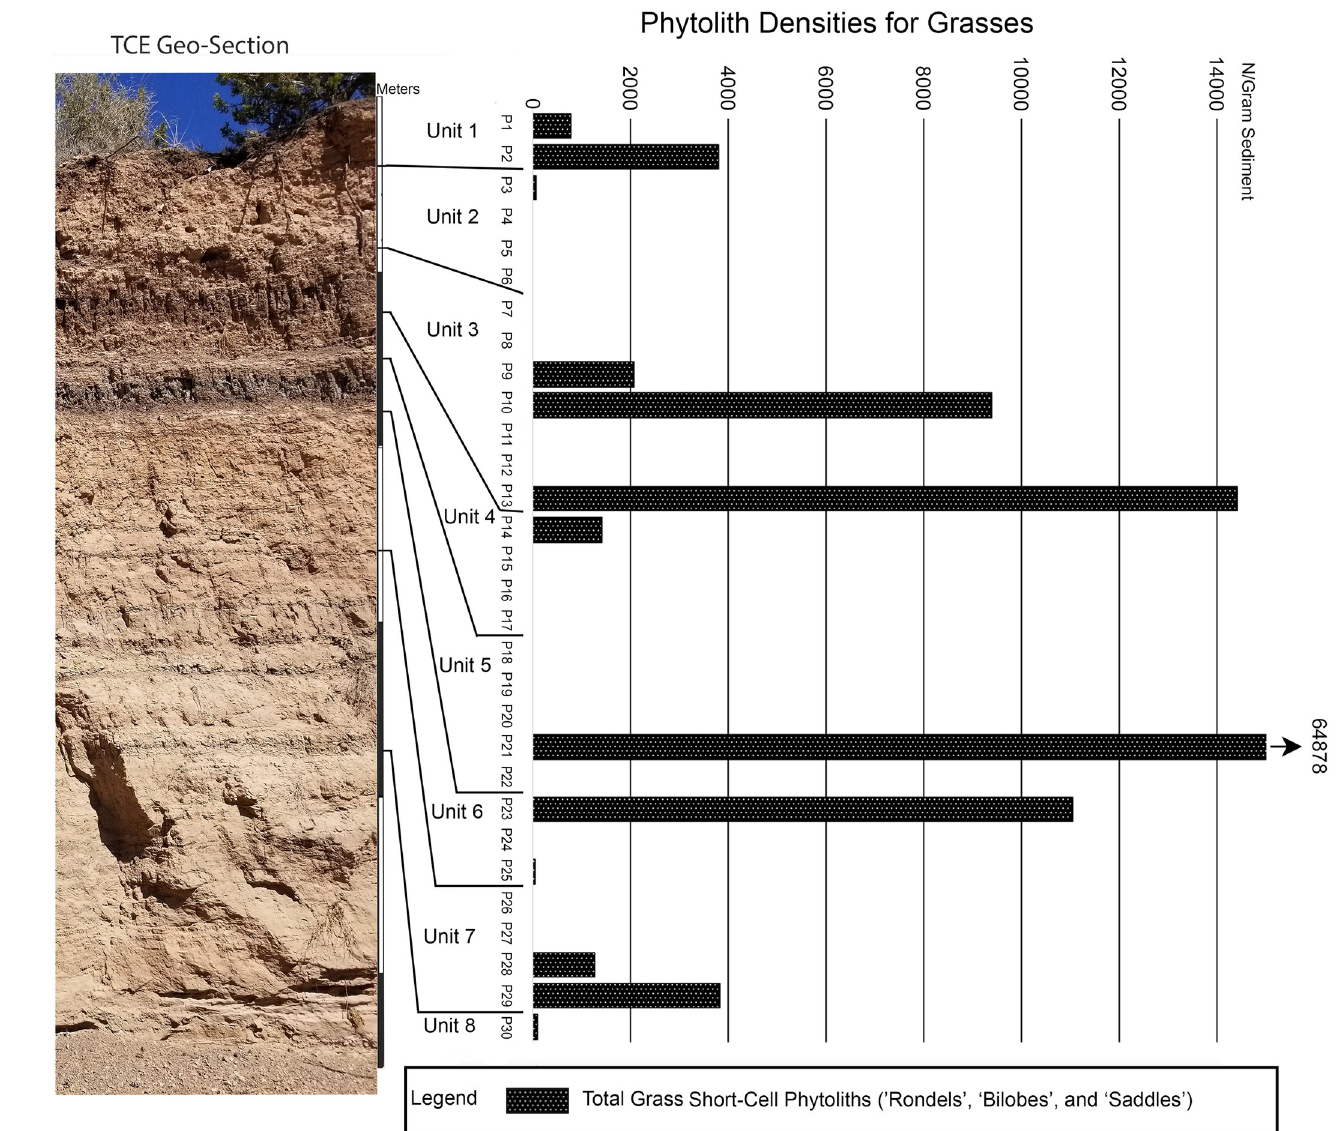
Fig 4. Tesuque Creek East Section with phytolith density results (n/gram) for the